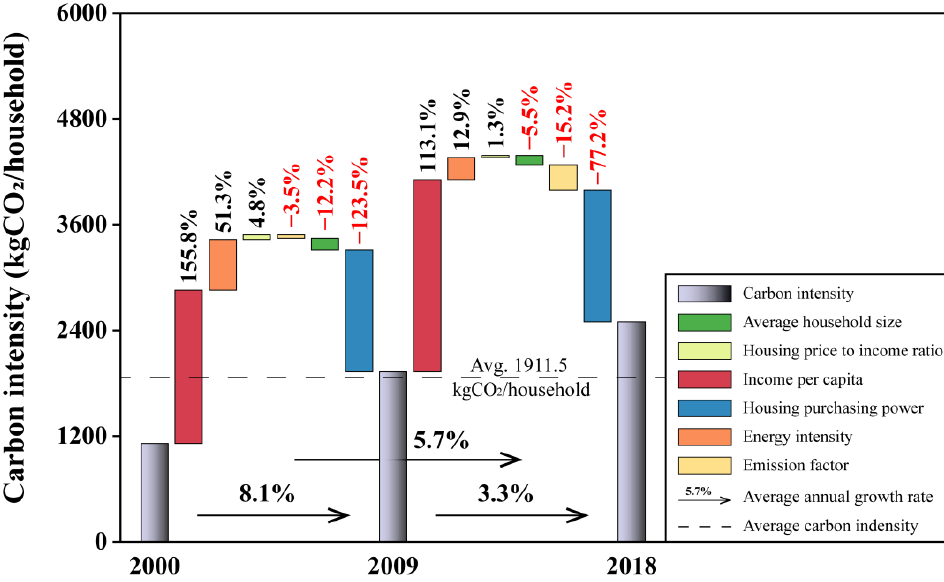
Figure 5. Variation in the operational carbon intensity of residential buildings at the national level (2000 –